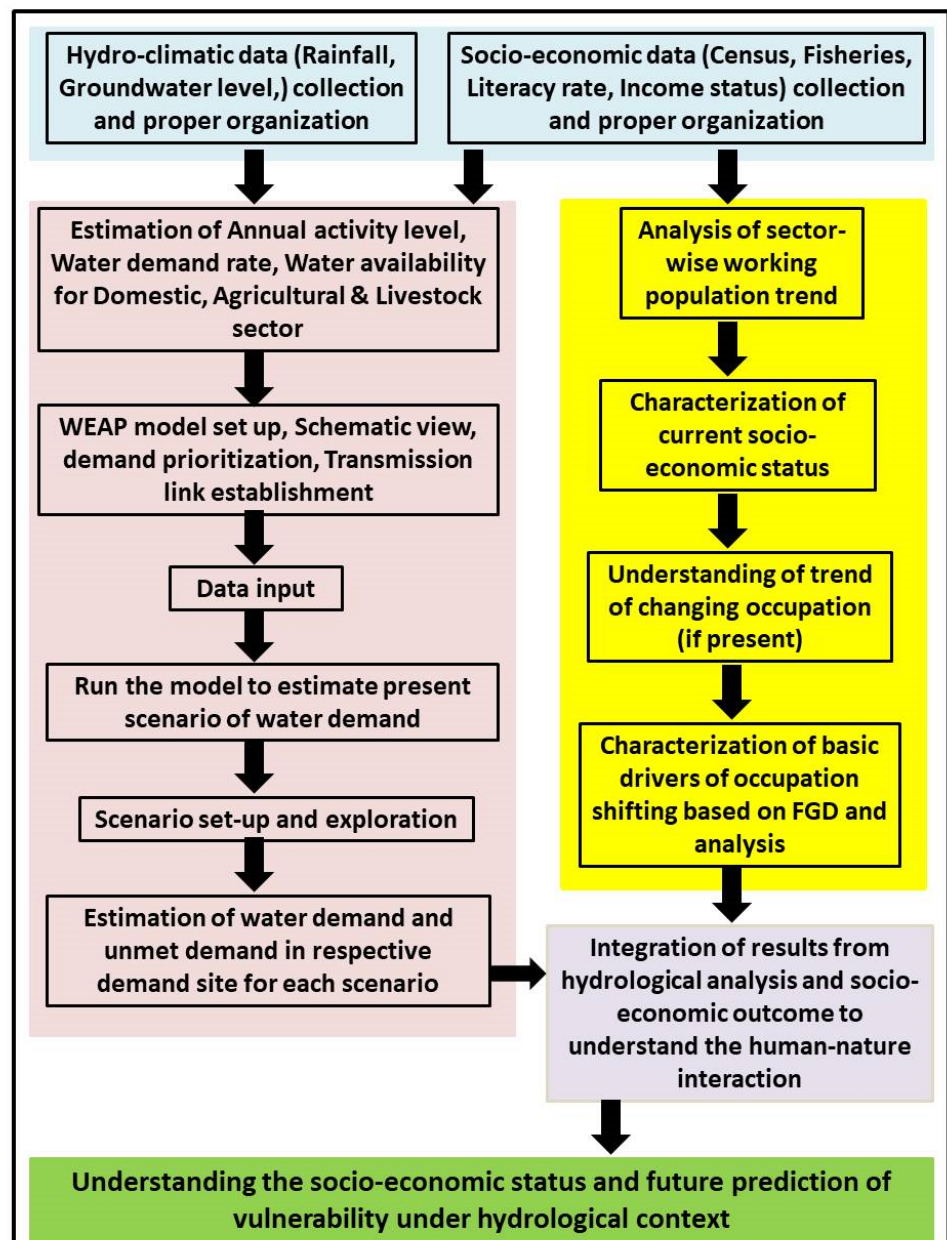
Figure 2. Flowchart of methodology (Blue color: Secondary data, Pink color: Hydrological data analysis in WEAP, Yellow color: Socio ‐ economic parameter analysis, Grey color: Incorporation of results, Green color: Conclusion).